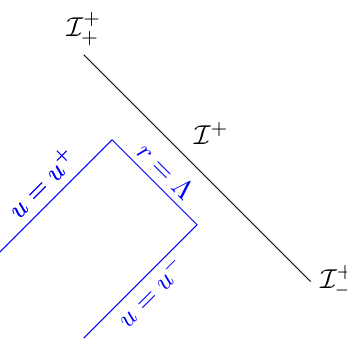
Figure 1. Contour for the variational